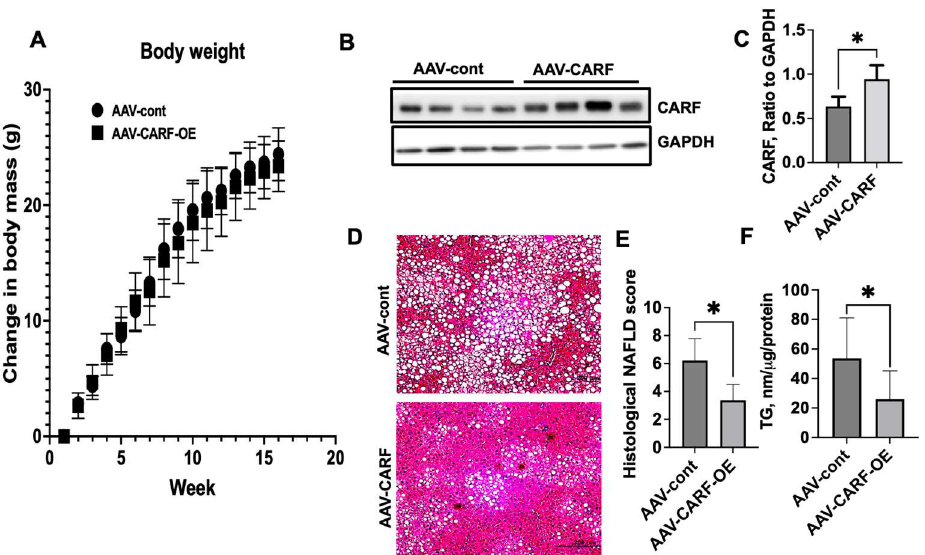
Figure 7. Exogenous expression of CARF attenuates lipid accumulation in liver. Male C57BL6 mice (7 weeks of age) were fed on an HFD for 16 weeks. Control and CARF-overexpressed (CARF-OE) mice ( n = 8) were transduced with AAV-9 particles expressing empty vector and CARF, respectively, at the 1st week of HFD feeding. Body weight was recorded weekly and compared with the control mice ( A ). Representative Western blotting images of CARF expression in the livers from control and CARF-OE mice ( B ). Quantitation of band intensities of CARF compared with GAPDH ( C ). Representative images of H&E-stained sections of livers collected from control and CARF-OE mice ( D ). Quantification of NAFLD score as revealed through H&E staining of the liver sections. Values are given as mean ± S.E.M., n = 4–5 per group ( E ). Total triglyceride level in the livers in the CARF-OE mice compared with control mice ( F ). Parametric, unpaired Student’s t -test was applied to compare between two groups. (* p < 0.05.) (* H&E-stained images were taken at 20 ×